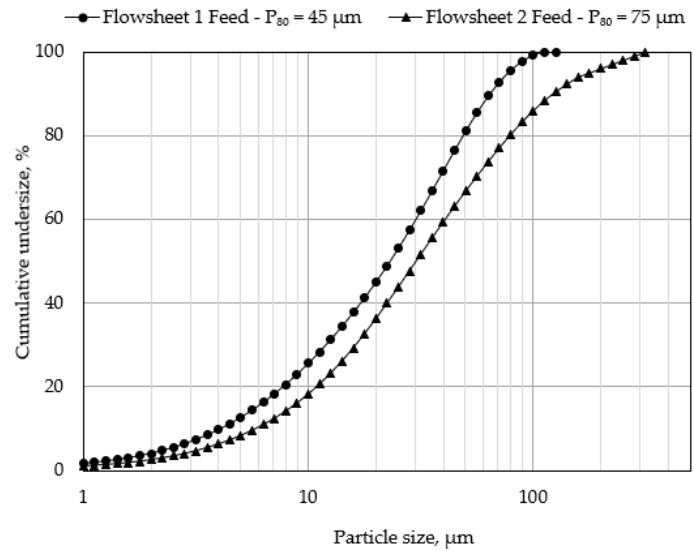
Figure 3. Particle size distributions of the various feed used in the study.